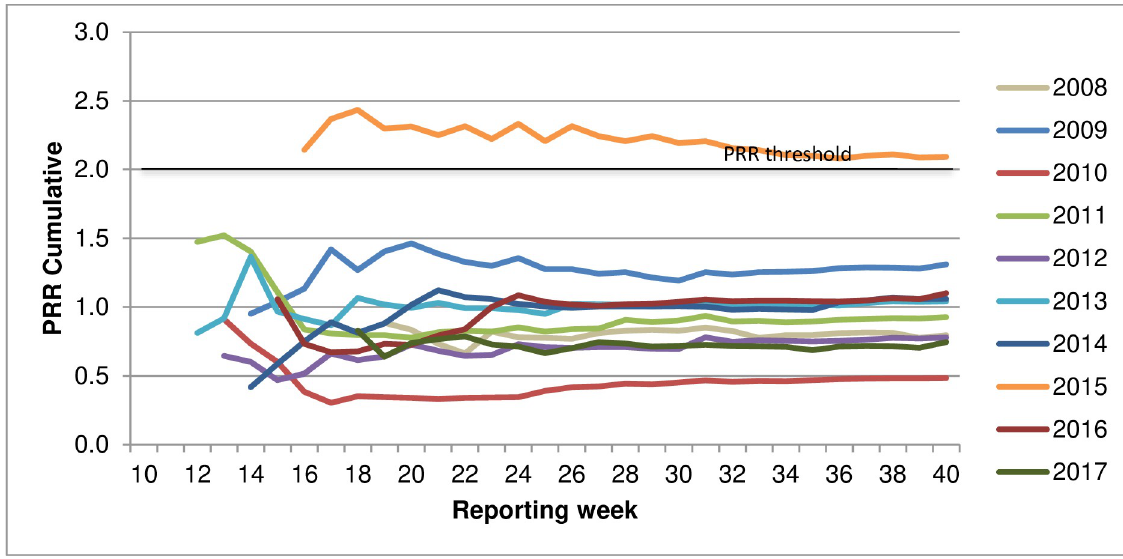
Fig 4. PRR cumulative (all previous years) for influenza vaccines & allergy, by year.